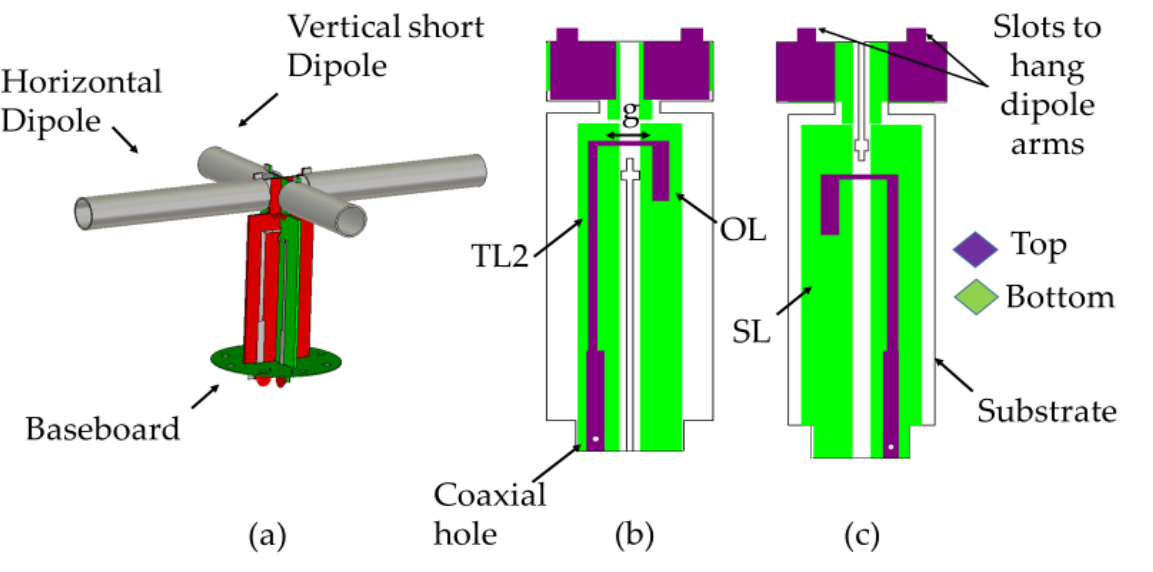
Table 3. Optimized parameters of the proposed antenna. Parameters. Figure 7. ( a ) Perspective view of the LBHV. The horizontal dipole is 135 mm long, and the vertical dipole is 60 mm long, ( b ) details of the LB horizontal dipole (LBHD) feed, ( c ) details of the LB vertical dipole (LBVD) feed. The configuration of horizontal dipole balun is shown in Figure 7b, while short dipole balun is depicted in Figure 7c. They are orthogonally arranged to feed the pair of horizontal and vertical LB arms. Although matching the short dipole is quite challenging, the antenna is well-matched with a reflection coefficient of better than 12 dB for horizontal polarization, and better than 10 dB for vertical polarization from 690 MHz to 960 MHz, as shown in Figure 8a. To have an insight into the working mechanism of the proposed antenna, VSWRs are studied and shown in Figure 8b. The optimized dimensions of the structure are those listed in Table 3. A fabricated prototype of the antenna is shown in Figure 9.